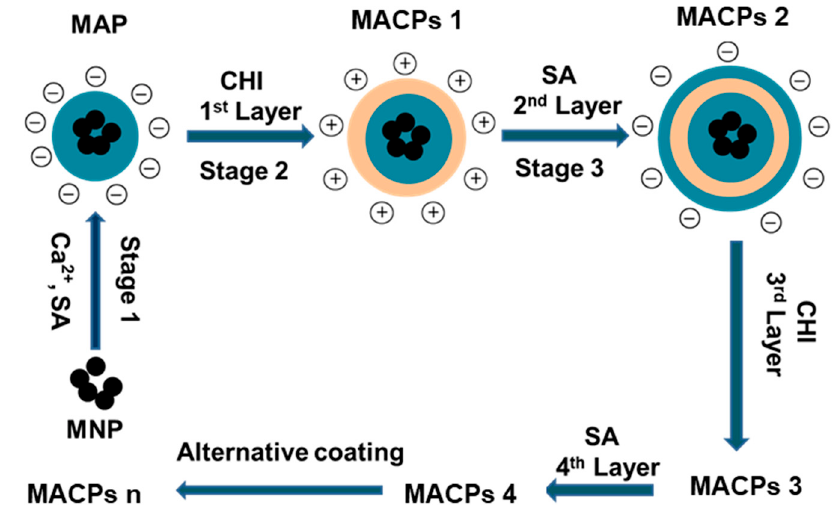
Scheme 1. Schematic illustration for the preparation of MAPs and MACPs. MAPs were fabricated by coating cross-linked alginate on MNPs using Ca 2+ as the cross-linker. MACPs were prepared by alternatively depositing CHI and sodium alginate (SA) on MAPs based on the electrostatic interaction between the two biopolymers. The alternative coating was repeated until MACPs with desired number of layers were obtained (Stage 2 and 3). MACPs 1, 2, 3, 4 and n represent CMACPs that possess 1, 2, 3, 4 and n layers of polymers coated on MNPs respectively.